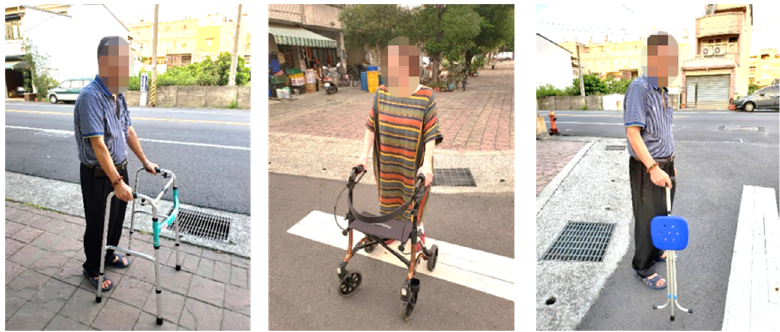
Figure 1. Walking aids (the images were shot by the authors).